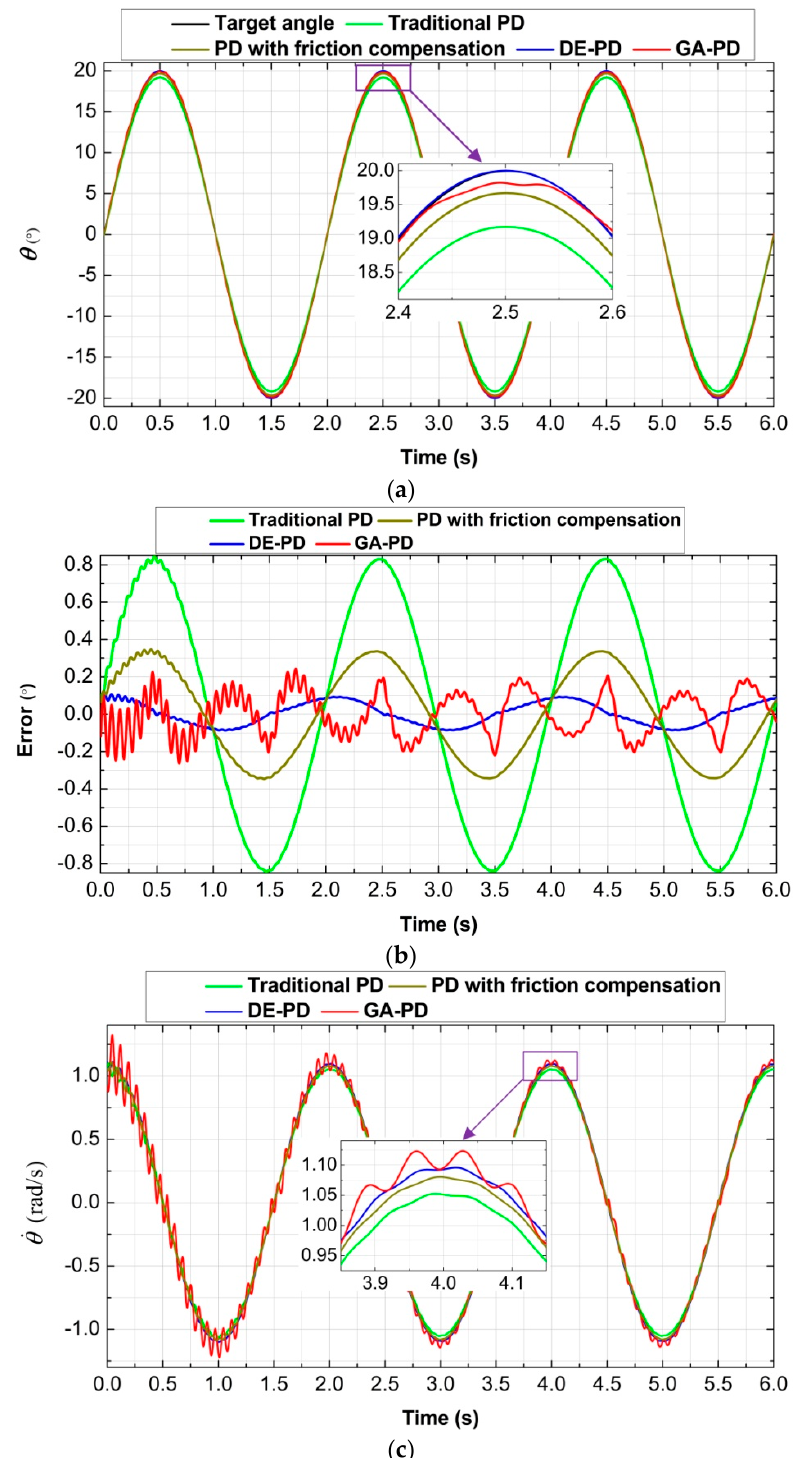
Figure 11. Position tracking performances under four control strategies. ( a ) Angle contrast curve; ( b ) error contrast curve; and ( c ) angular velocity contrast curve.